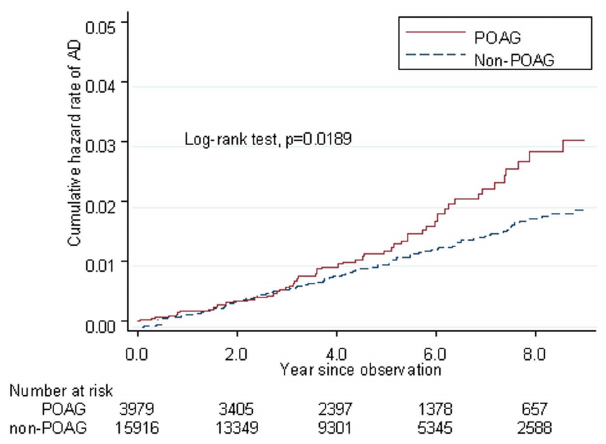
Figure 1. Kaplan-Meier failure curve of patients with POAG and non-POAG who developed AD after accounting for censoring due to death or end of observational period.